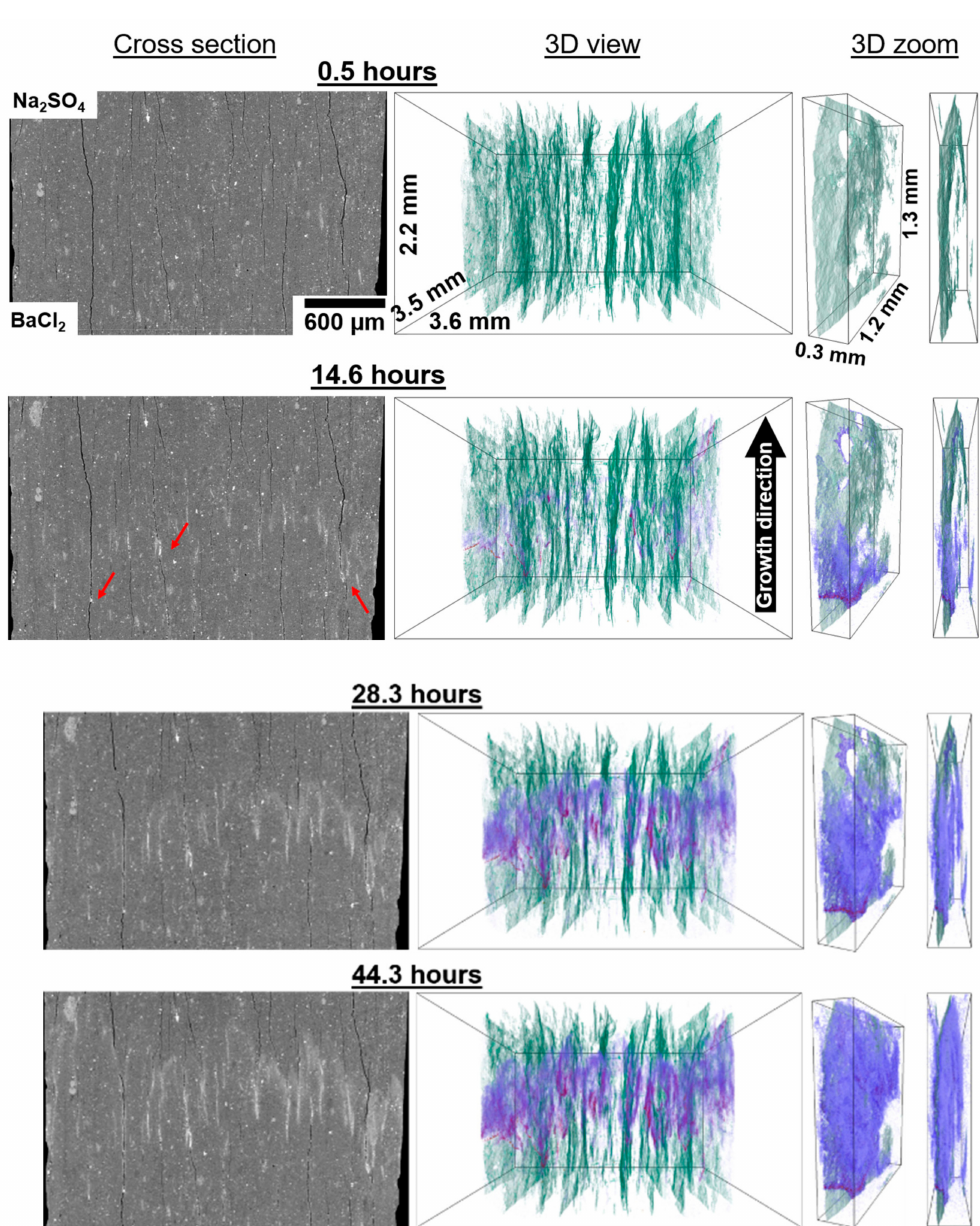
Figure 2. Virtual CT cross-sections of the sample perpendicular to the fractures and parallel to the mixing direction, and 3D views of the entire sample’s diameter and of a subvolume of the sample at two angles, at 0.5, 14.6, 28.3, and 44.3 h. 2D sections are shown in a grey-scale where fractures are black, barite is white, and grey levels represent minerals in the shale matrix. 3D views show the fractures wider than 3.2 µ m (green) and the precipitates. Precipitates are coloured based on the volume fraction of crystals within a voxel in the order of decreasing densities: magenta, purple, blue (linear gradient). Red arrows highlight points where precipitates are first observed (note that they appear in the larger fractures and few crystals are observed to grow beyond these points and within the same fracture. See Videos 1 and 2 for full time-lapse